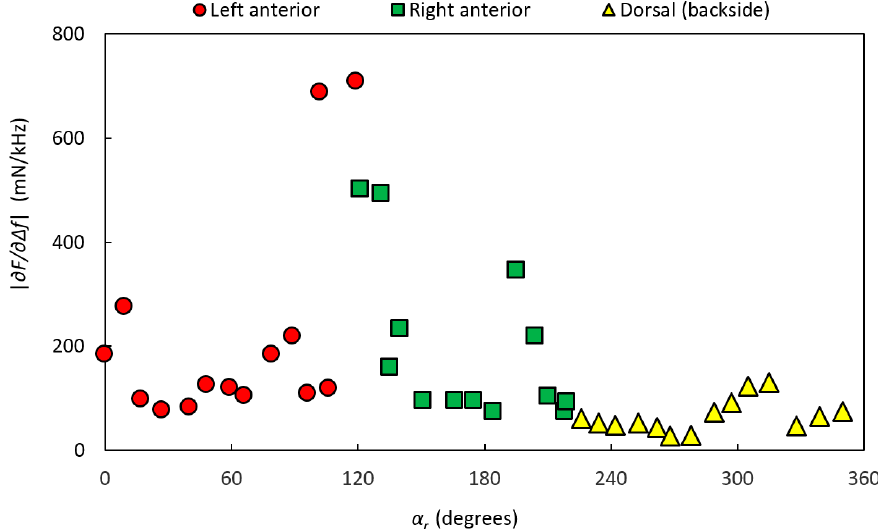
Figure 13. The stiffness parameter | ∂ F / ∂ ∆ f | of P-2 as a function of the rotational angle, α r , along the circumference of the gland. The prostate gland was clamped with the clamping force F C = 460 ± 85 mN in the rotatable holder. The data are divided into dorsal, left anterior, and right anterior according to the dyed areas made by the pathologist.